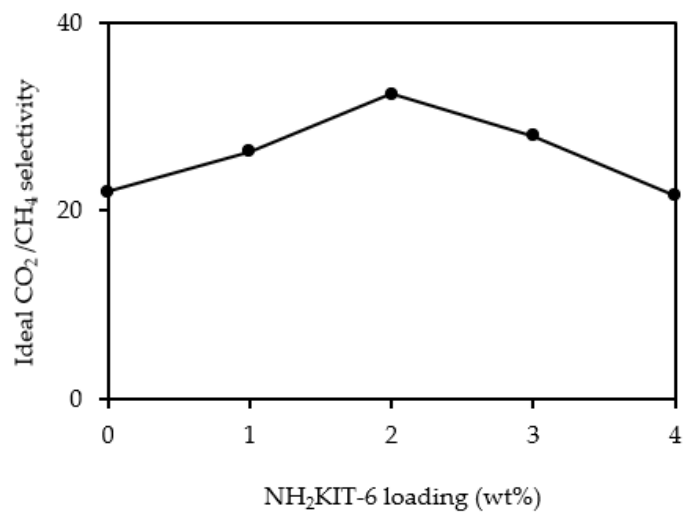
Figure 10. Ideal CO 2 / CH 4 selectivity of the membranes incorporated with di ff erent NH 2 KIT-6 loadings at a pressure di ff erence of 5 bar. Table 1. Comparison of CO 2 permeability and ideal CO 2 /CH 4 selectivity between MMMs from current study and MMMs incorporated with functionalized silica reported in the literature.